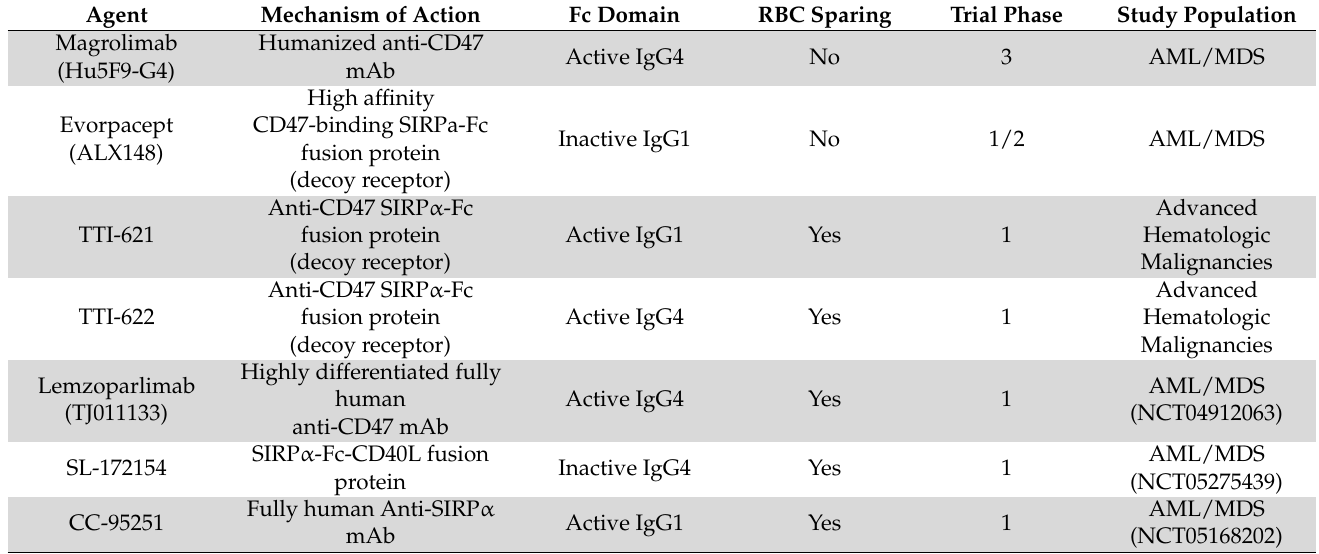
Table 2. CD47-SIRP α Targeting Agents under Investigation in Myeloid